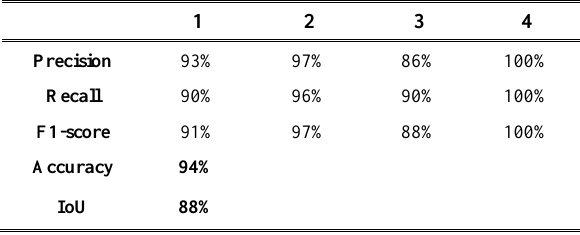
Table 3 . Evaluation of the of the UNET model through a few common metrics with land cover types indicated as follows: 1 = built-up, 2 = vegetation, 3 = barren land, 4 = water body.